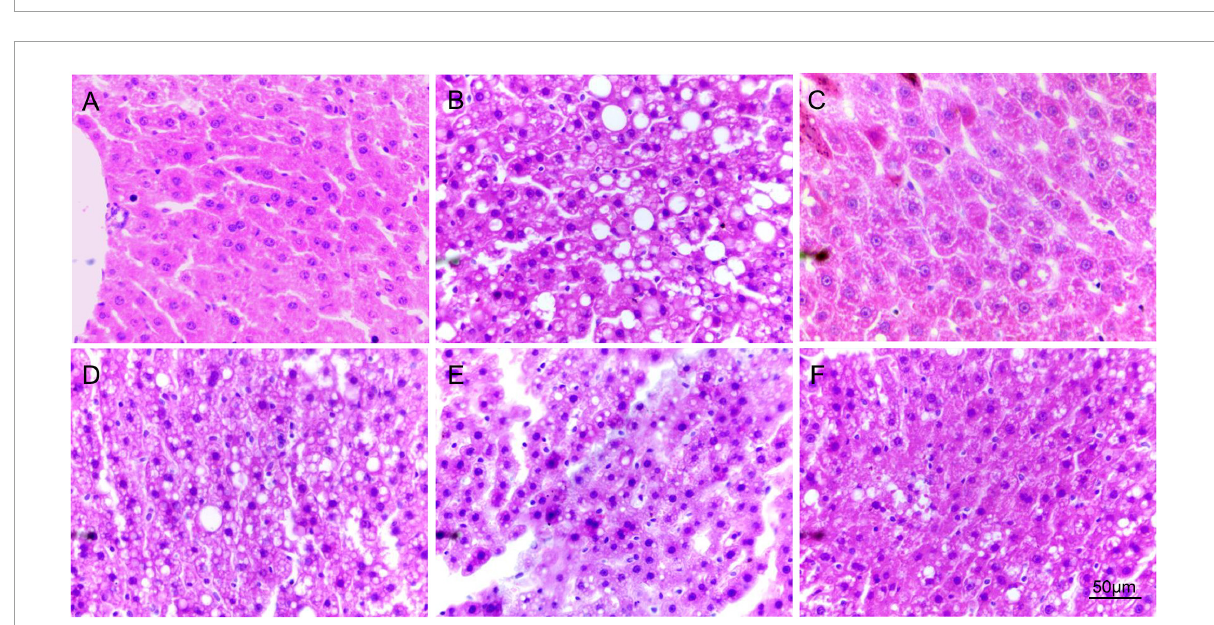
FIGURE4 The images of H&E staining in the liver. (A–F) are the H&E staining pictures of liver slices in the control, model, simvastatin, low-dose, high-dose, and compound group, respectively.